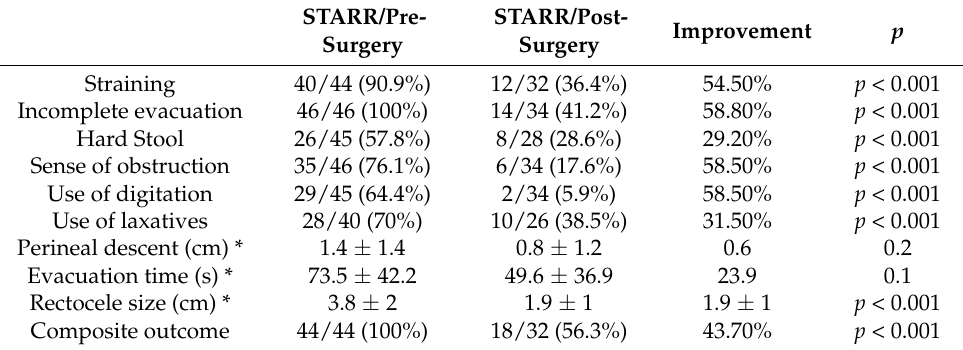
Table 4. Presurgical vs. postsurgical evaluation in the STARR group.